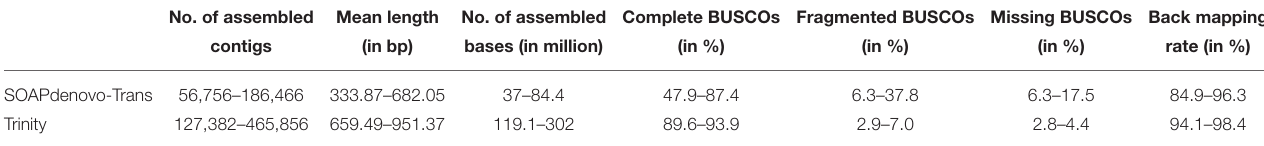
TABLE 2 | Summary of statistics of de novo transcriptome assemblies using SOAPdenovo-Trans and Trinity (BUSCO, Benchmarking Universal Single-Copy